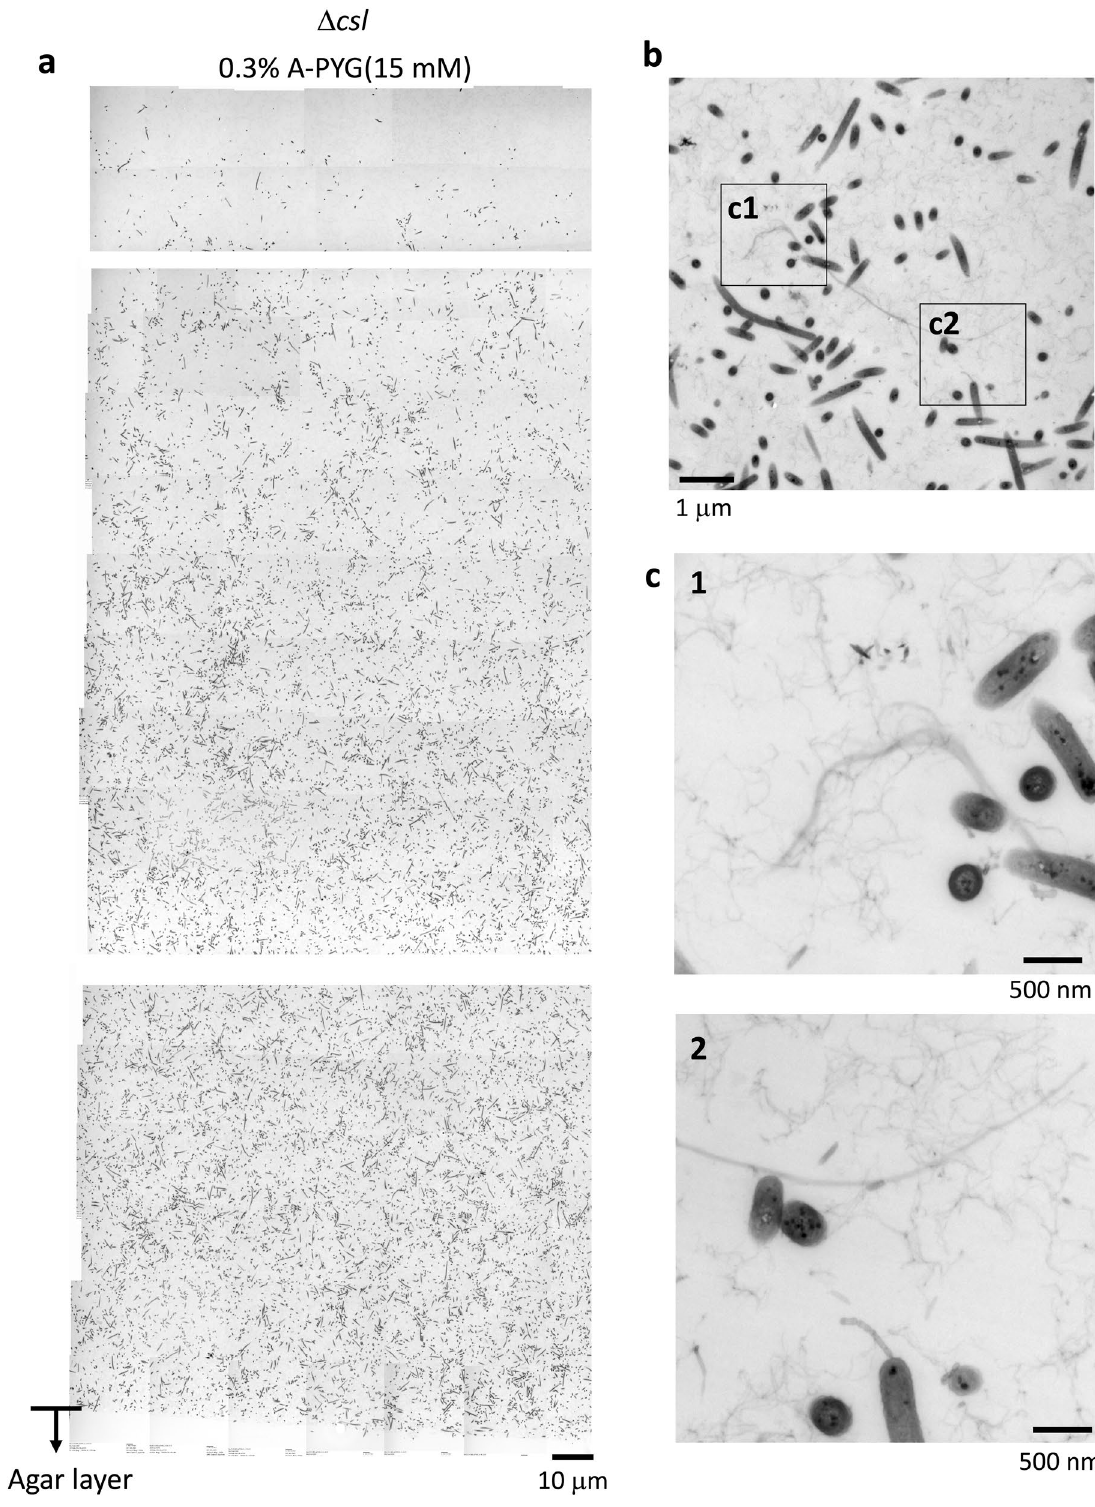
Figure 6. TEM of Δ csl mutant F. johnsoniae spreading colonies on 0.3% A-PYG (15 mM). Colonies were embedded in Epon resin, sliced into 70-nm serial sections, and observed by TEM. ( a ) Sections of Δ csl F. johnsoniae colonies. Similar to the WT and Δ sprB , the cells were interspersed within the intercellular matrix. ( b ) TEM image of a 400 nm-thick, unstained, Epon section of a Δ csl mutant colony spread on 0.3% A-PYG (15 mM). The intercellular space between bacterial cells was occupied by fibers and vesicles. ( c ) Higher magnification images of the squares in ( b ). Again, similar to WT and Δ sprB , the intercellular matrix was occupied by many intertwined fibers and secreted vesicles, suggesting biofilm